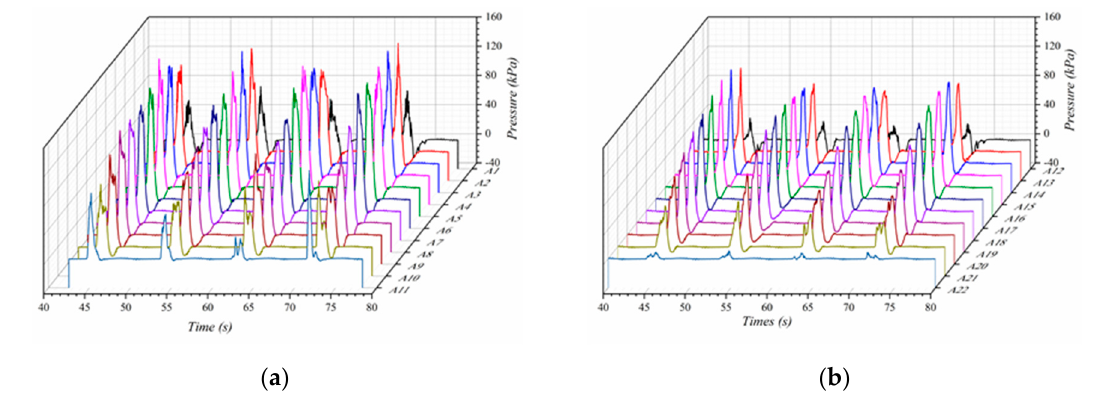
Figure 20. ( a ) Time history of slamming pressure at A1–A11 ( b ) Time history of slamming pressure at A12–A22.